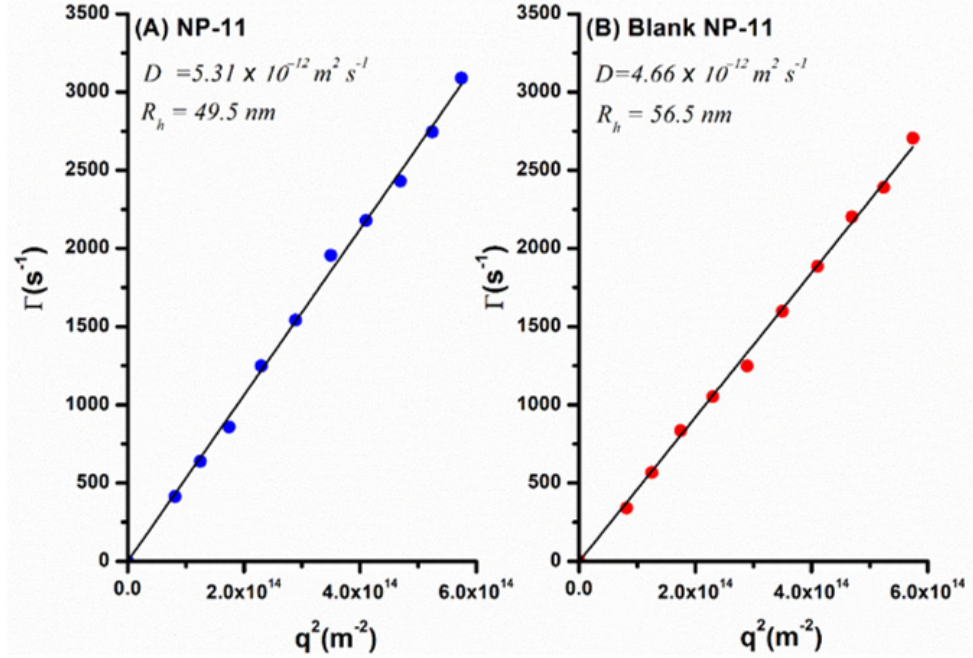
Figure 3. Dependence of relaxation frequency Γ (s − 1 ) on the square of wave vector modulus (q 2 ) for ( A ) NP-11 and ( B ) blank NP-11.